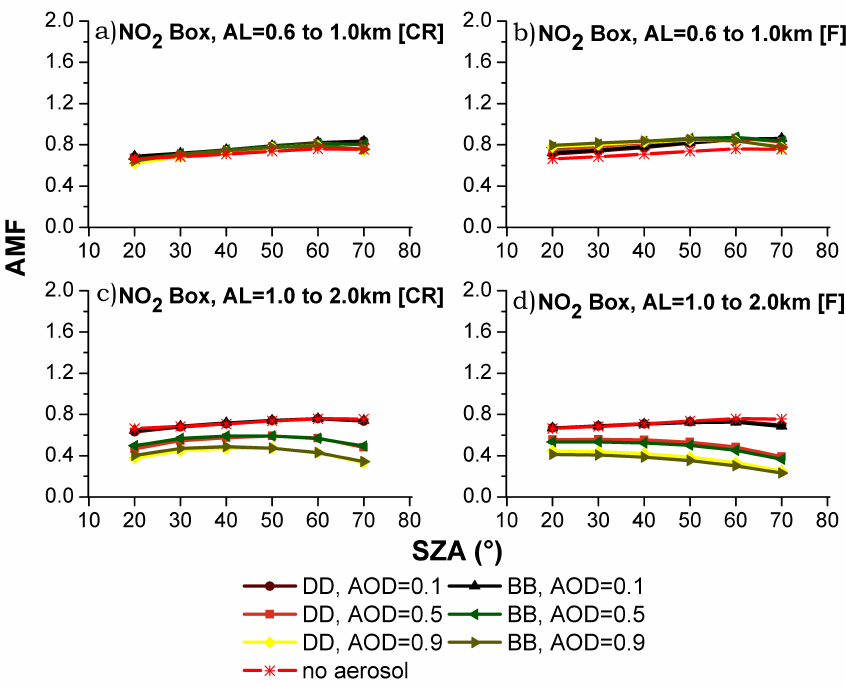
Fig. 9. NO 2 airmass factors for a 1.0km box NO 2 profile using no aerosol (red) and also for scenarios D (a) , (b) and E (c) , (d) (elevated aerosol layers (AL) from 0.6 to 1.0km and 1.0 to 2.0km, respectively) calculated with the phase functions determined for (a) , (c) coarse (CR) and (b) , (d) fine (F) particles (optical properties taken from Amazonian Forest/Brazil and from Saudi Arabia AERONET stations, respectively for the biomass burning (BB) and desert dust (DD) cases). AMF determined at 440nm, with surface albedo = 0.03, ω 0 = 0.93 and different AODs: 0.1, 0.5 and